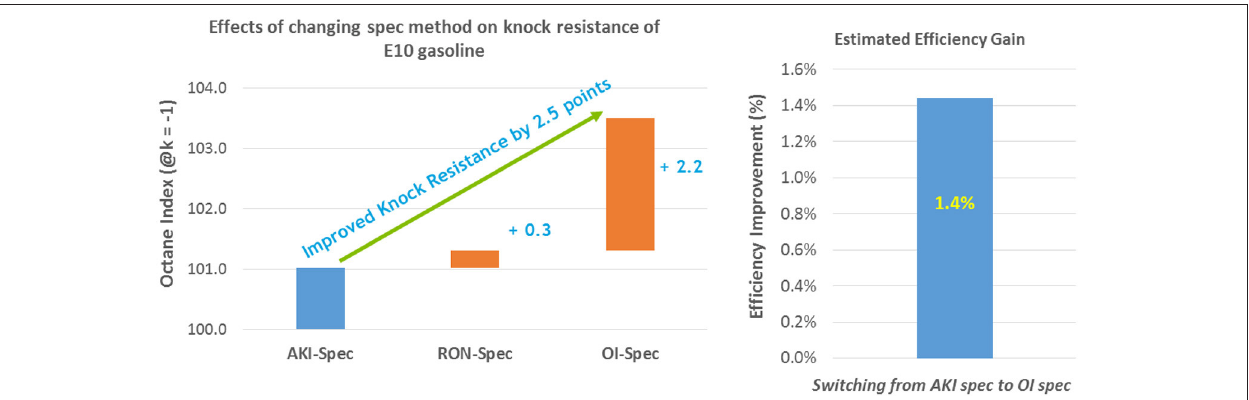
FIGURE 12 | Switching from AKI-based specification (AKI = 88) to an equivalent OI specification (OI = 103) can lead to improved gasoline knock resistance of about 2.5 points. Using Leone et al.’s correlations, this can enable up to 1.5% efficiency gain in a turbocharged SI engine due to higher compression ratio.